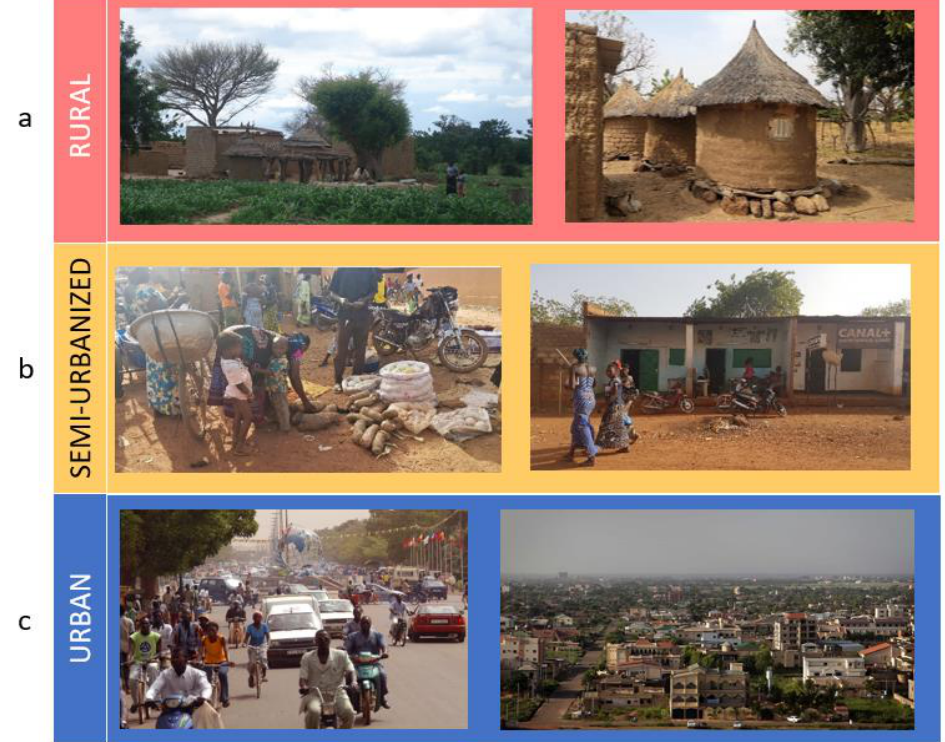
Figure 2. Life in Burkina Faso. ( a ) Rural village (Boulpon), ( b ) semi-urbanized area (Nanoro town), ( c ) the capital city Ouagadougou. Personal photographs taken by Paolo Lionetti and Silene Casari.